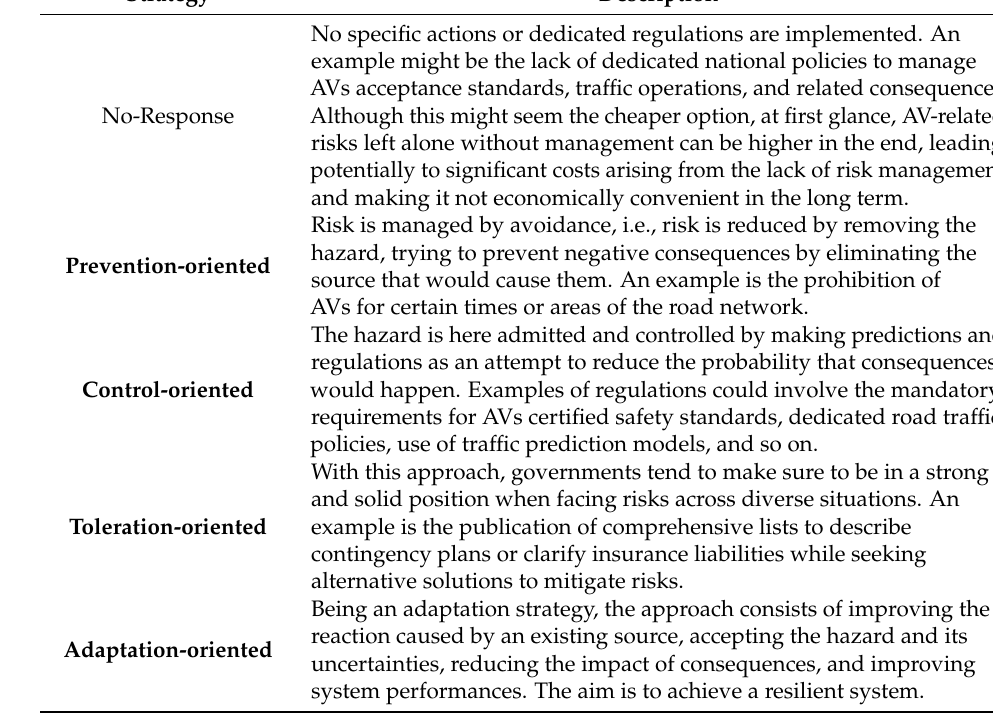
Table 1. A brief description of several strategic approaches